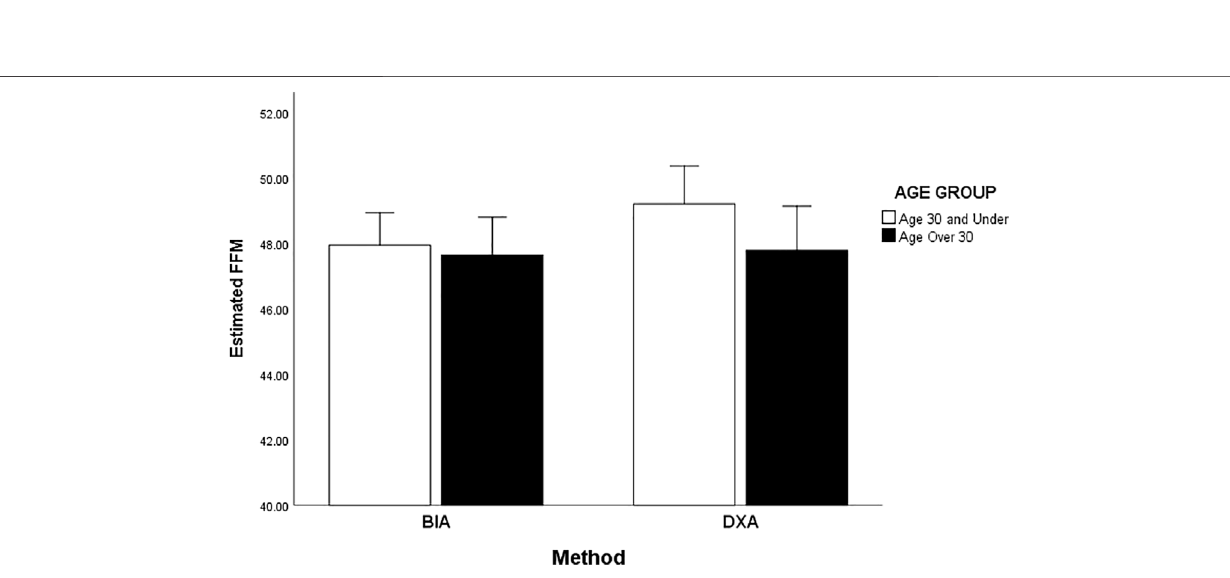
Frontiers in Physiology |